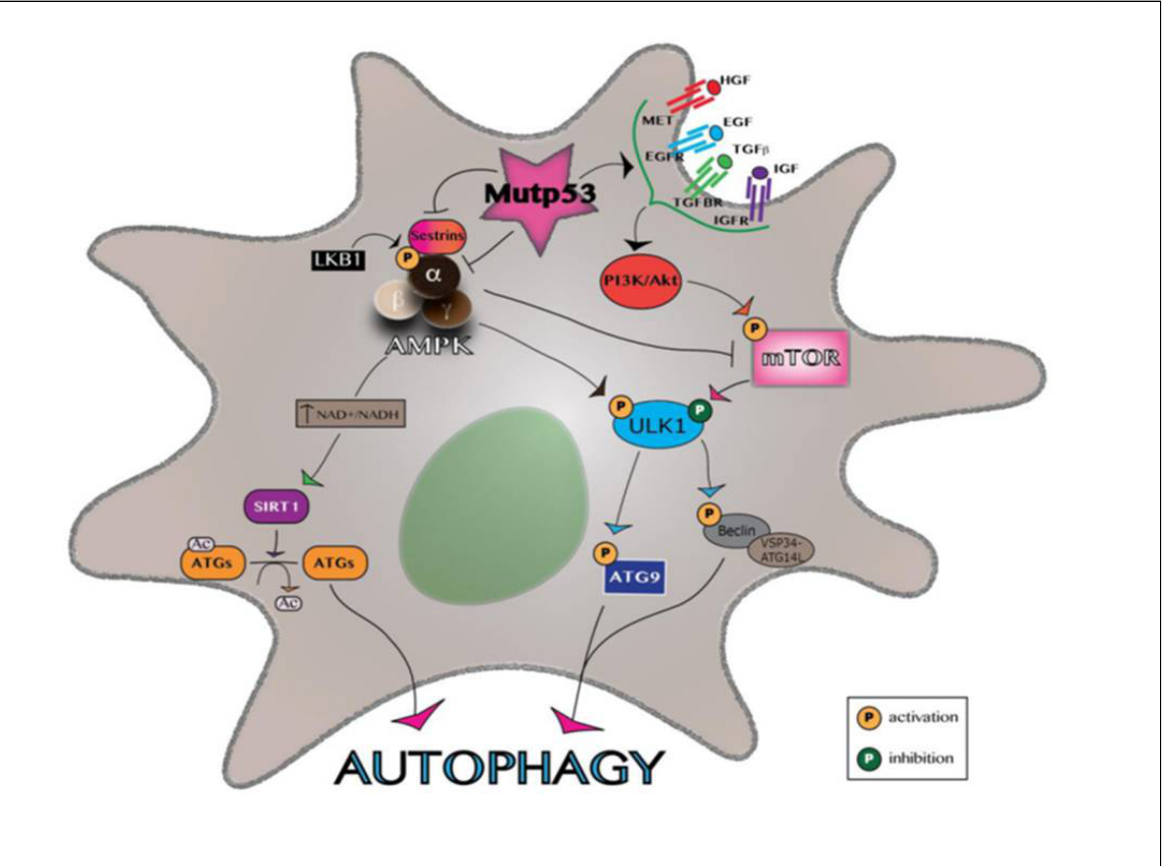
Figure 3: Schematic representation of molecular mechanisms by which p-53 mutant proteins inhibit AMPK and stimulate mTOR pathways that block autophagy. (Cordani M, Butera G, Pacchiana R, Donadelli M. Molecular interplay between mutant p53 proteins and autophagy in cancer cells. BBA - Reviews on Cancer 2016; 8: 1-34.